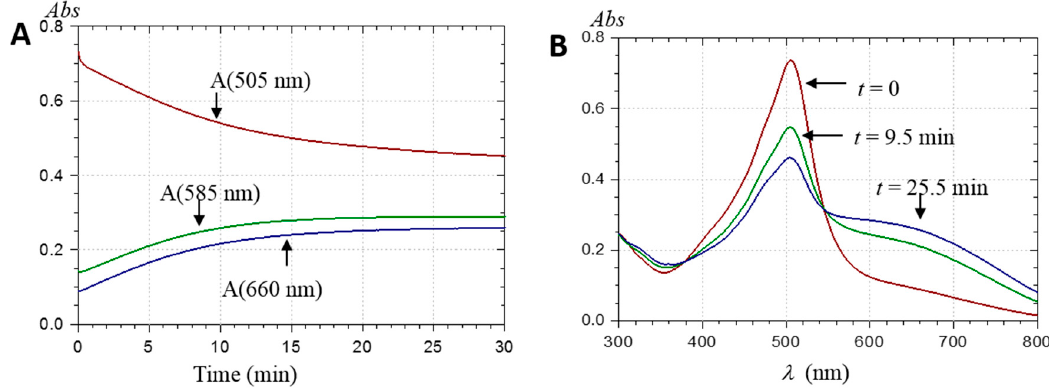
Figure 5. ( A ) Changes in visible absorbance ( Abs ) following the addition of PA1 (48.4 µM) to a pH 4.39 acetate buffer + 12% EtOH; and ( B ) UV-visible spectra at different time points.